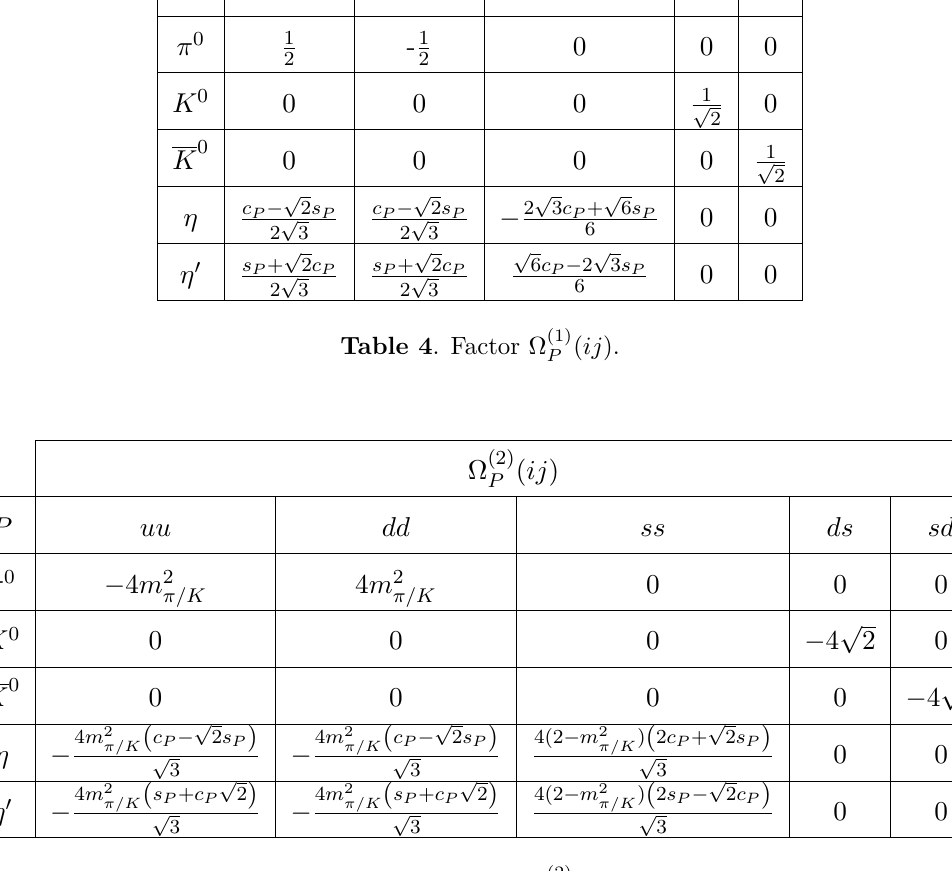
Table 5 . Factor Ω (2)